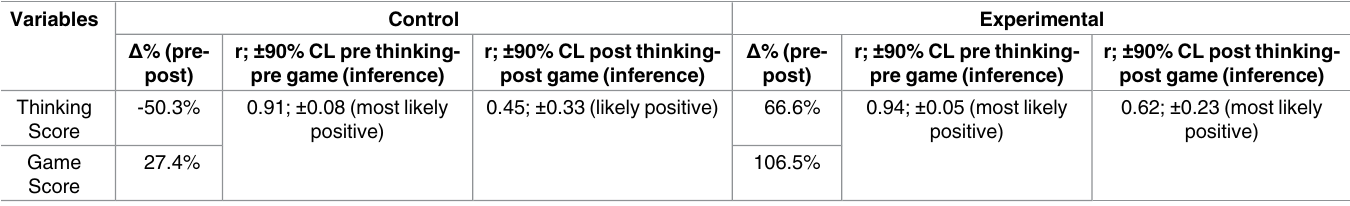
Table 3. Inferential statistics of thinking and game pre-post variation and the coefficient correlation between pre-pre and pre-post of the control and experimental groups.